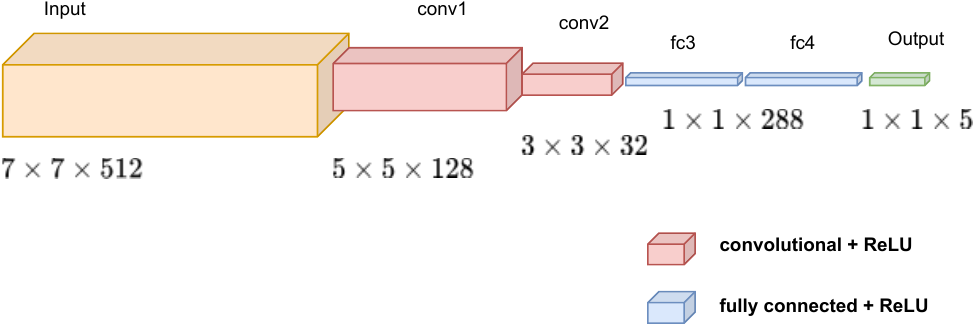
Figure 6. The architecture of the policies is a convolutional neural network. The input to the Neural Network is a fixed size 7 × 7 × 512 from the latent space representation. The output is a vector composed of the values of [ accelerator , brake , clutch , gear , andsteering ]